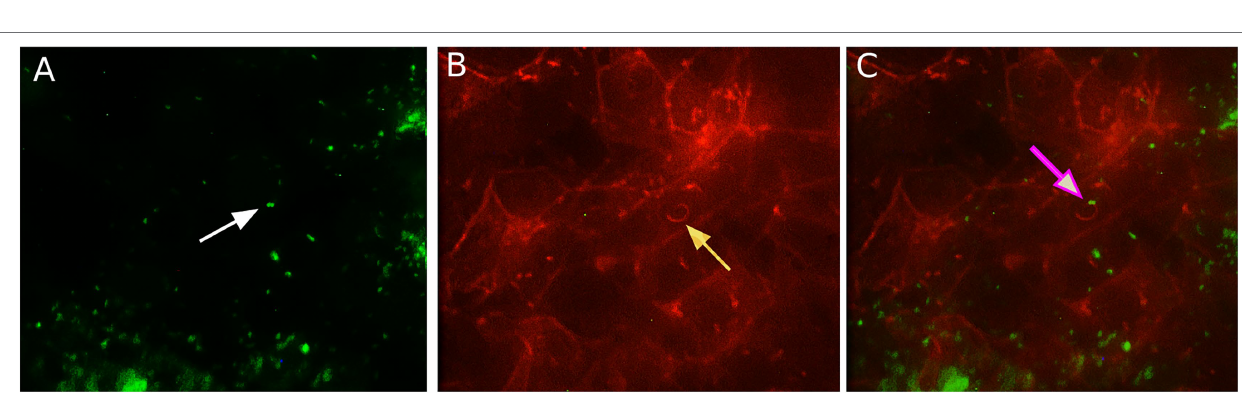
FIGURE 2 | The nondotted line indicates Listeria monocytogenes invading and reproducing in ovine kidney cells. Approximately 1 × 10 5 shKEC cells were infected with a multiplicity of infection (MOI) of 100, and the numbers of intracellular bacterial cells were determined 2, 4, 6, and 8 h after infection. Mean ± SD from three experiments conducted in triplicate are shown. The dotted line is the trend line.